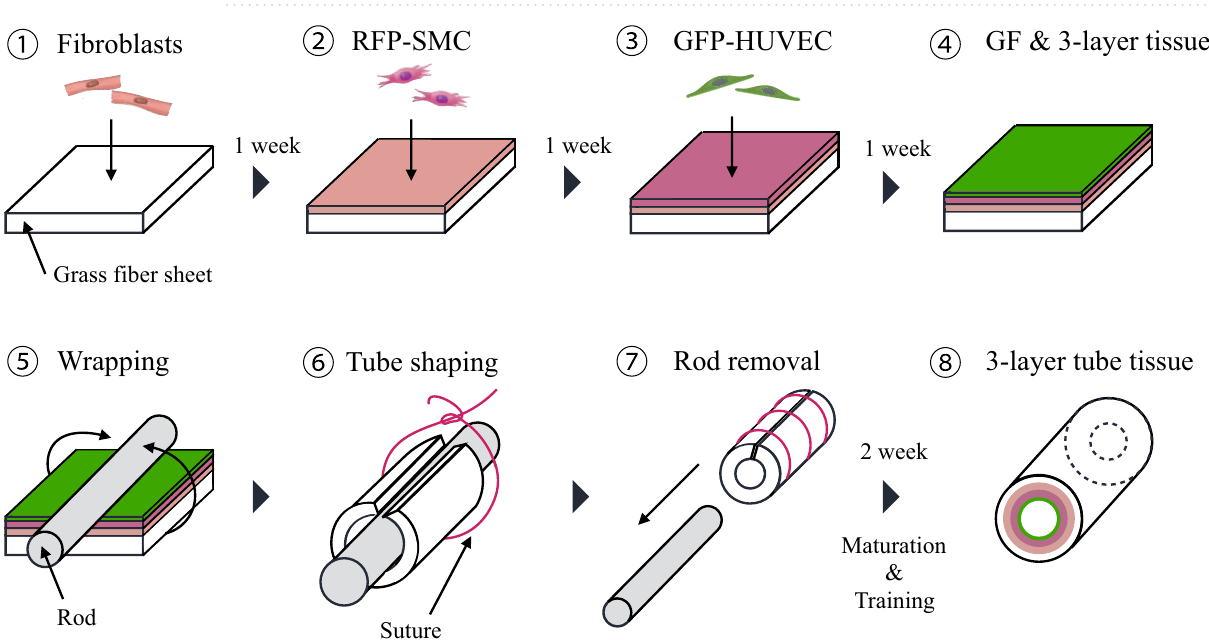
Figure 12. Tensile strength measurement tester device. ( A ) The developed tensile holder. ( B ) Overall appearance of the device assembled with the Load/Displacement Measurement Unit and digital force gauge. A part of the image was created by the rendering function of SOLIDWORKS 2018.